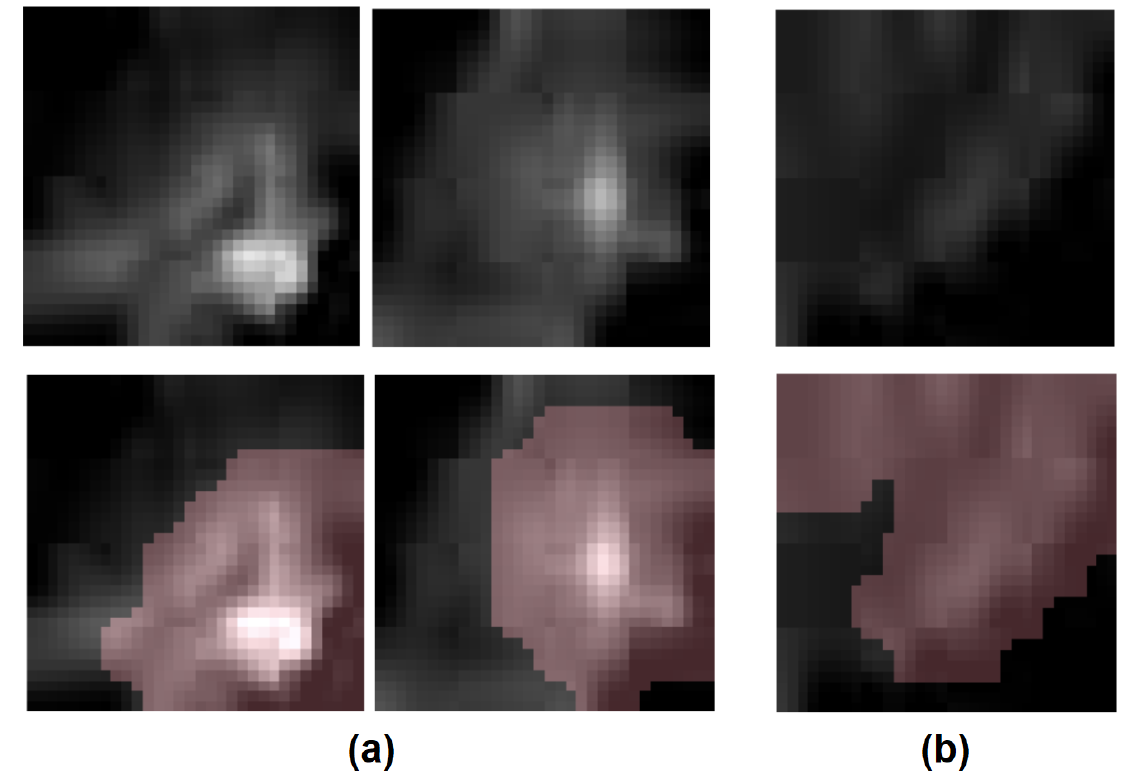
Figure 7. Visualization of Zone-DR critical regions on CHB-DWI sensing data using GSInquire [37]. ( a ): positive zone examples, ( b ): negative zone examples. Top: CHB-DWI sensing data, Bottom: corresponding critical region visualization with identified critical regions overlaid on their respective sensing data